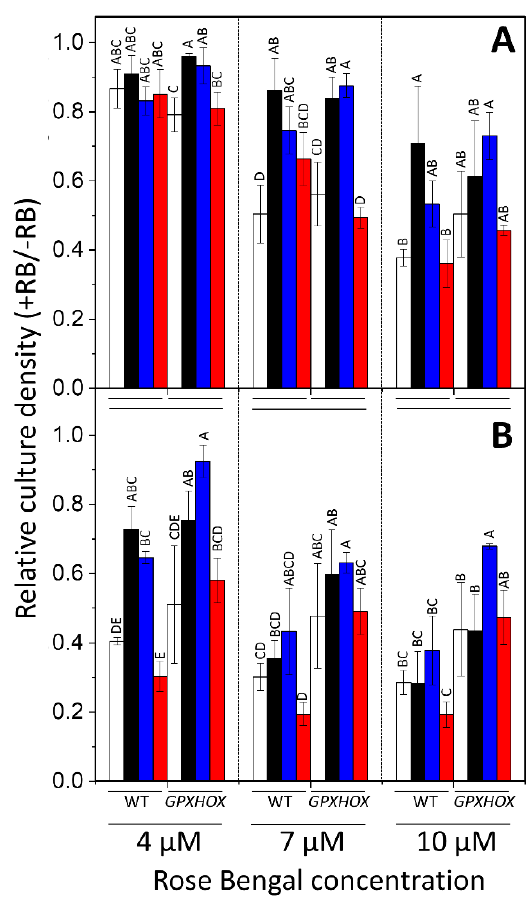
Figure 4. Influence of GPX5 -overexpression and effect of HL, β -cyclocitral, and acrolein pre-treatments on tolerance to 1 O 2 . Tolerance to 1 O 2 was tested by exposing WT 4A or GPXOX-11 cultures to ( A ) 250 μmol photons m −2 s −1 for 10 min or ( B ) 50 μmol photons m −2 s −1 for 24 h, in a medium that initially contained 4 μM, 7 μM, or 10 μM of rose bengal (RB). Before treatment with RB, cells were from LL (control; white) or pre-treated with 4 h of HL (black), 600 ppm of acrolein (blue) or 600 ppm of β-cyclocitral (red) under LL. To reveal tolerance to 1 O 2 , cell density was monitored for 24 h after RB treatment by turbidity of culture at 650 nm and is shown relative to turbidity of the respective pre-treated cultures not treated with RB. Bars labelled with different letters within the same RB treatment denote significant differences from each other (Tukey’s post hoc after arcsine transformation, p < 0.05, n = 3 ± SD).